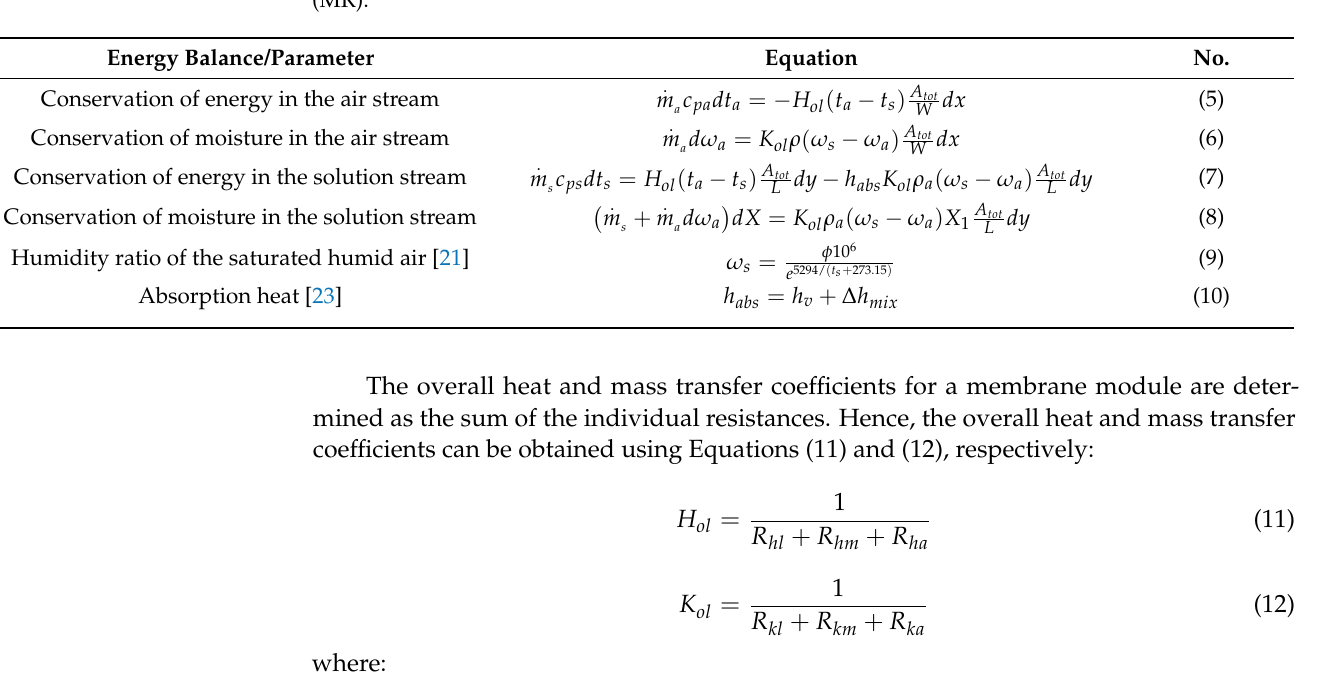
Table 3. Mathematical model equations for membrane dehumidifier (MD)/membrane regenerator (MR).